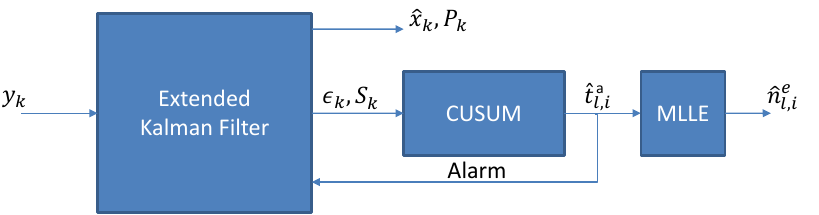
Figure 7. Architecture of the change point localization algorithm. MLLE stands for Maximum Likelihood Localization